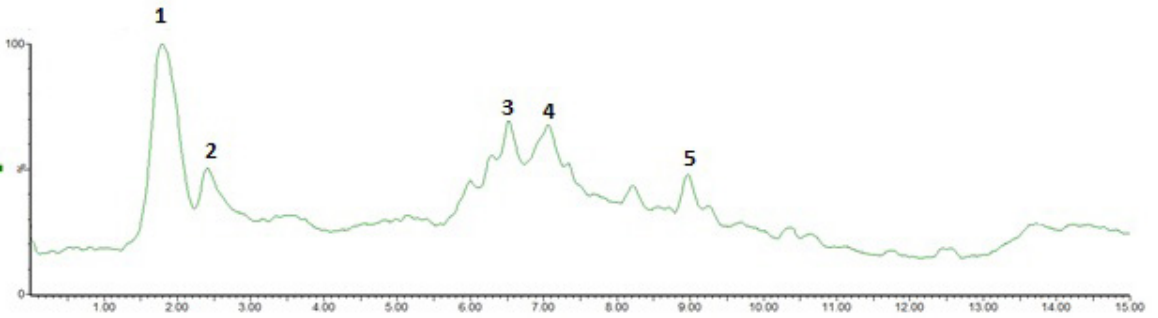
MineralsMonosaccharidesAmino acidsFatty